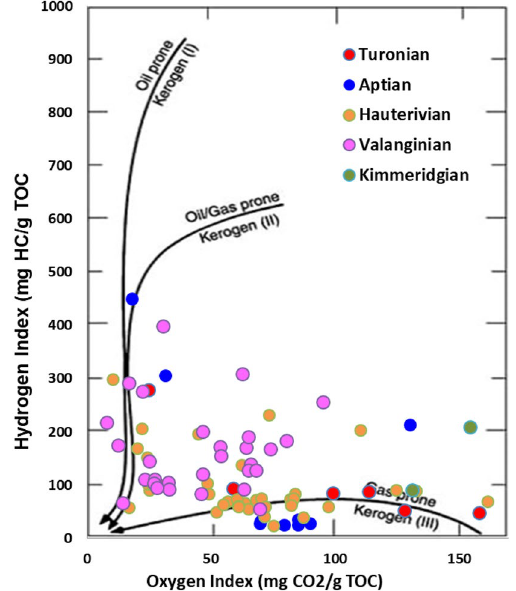
Fig. 7 Cross-plot of sample distribution illustrating kerogen types (quality) with the character of expelled products at peak maturity adapted from Agbor